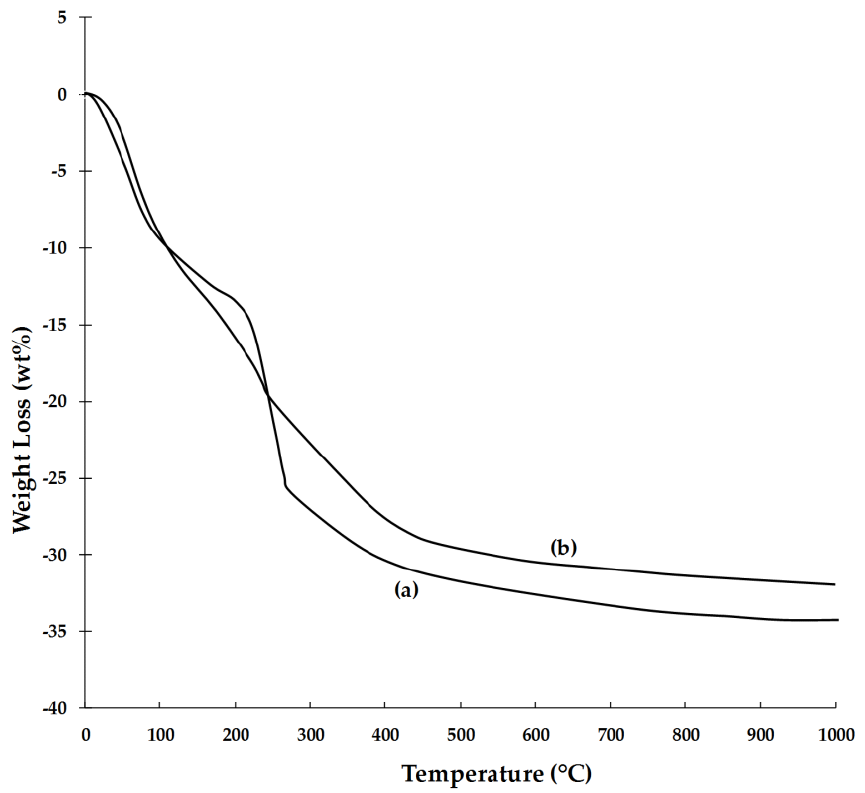
Figure 4. TGA curve samples: ( a ) 10 wt% ZrO 2 -Al 2 O 3 -CeO 2 ; ( b ) 1 wt% ZrO 2 -Al 2 O 3 MgO-CeO 2 . Desorption of physically bound water (adsorbed and crystallization) corresponds to the first endothermic effect in the temperature range 30–180 ◦ C (Table 2). The second endothermic effect in the temperature range 180–310 ◦ C is associated with the removal of coordinated water from the bayerite structure, and the formation of two phases: boehmite and low-temperature aluminum oxide ( η -Al 2 O 3 ). In this temperature range, dehydration of zirconium hydroxide occurs with the formation of cubic zirconium dioxide.